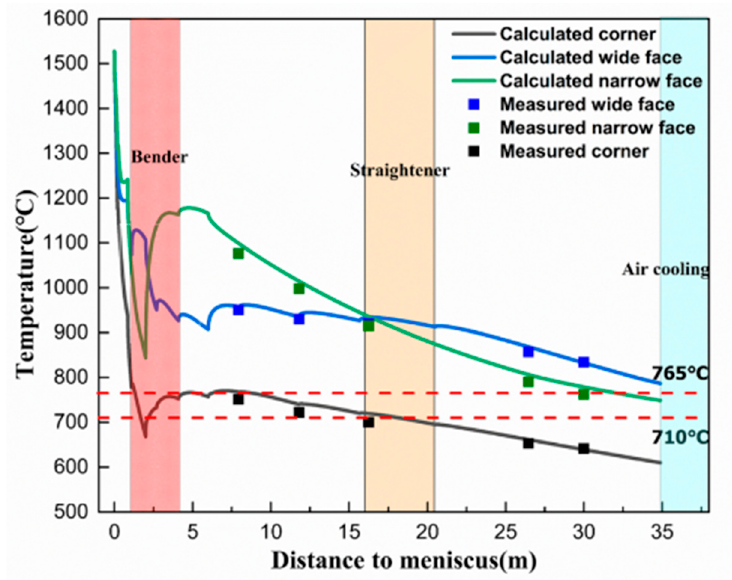
Figure 6. Surface temperature field of continuous casting slab.